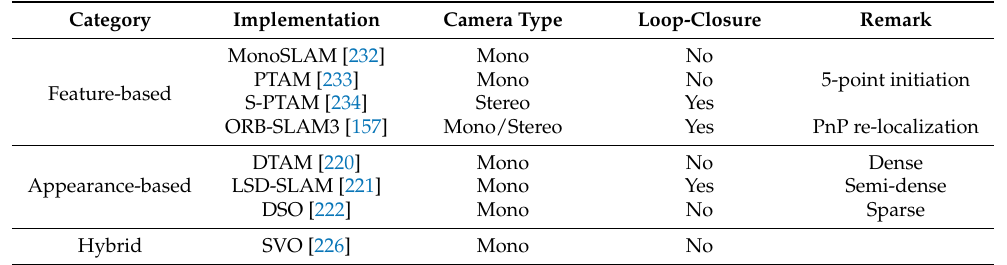
Table 4. Summary of representative visual odometry